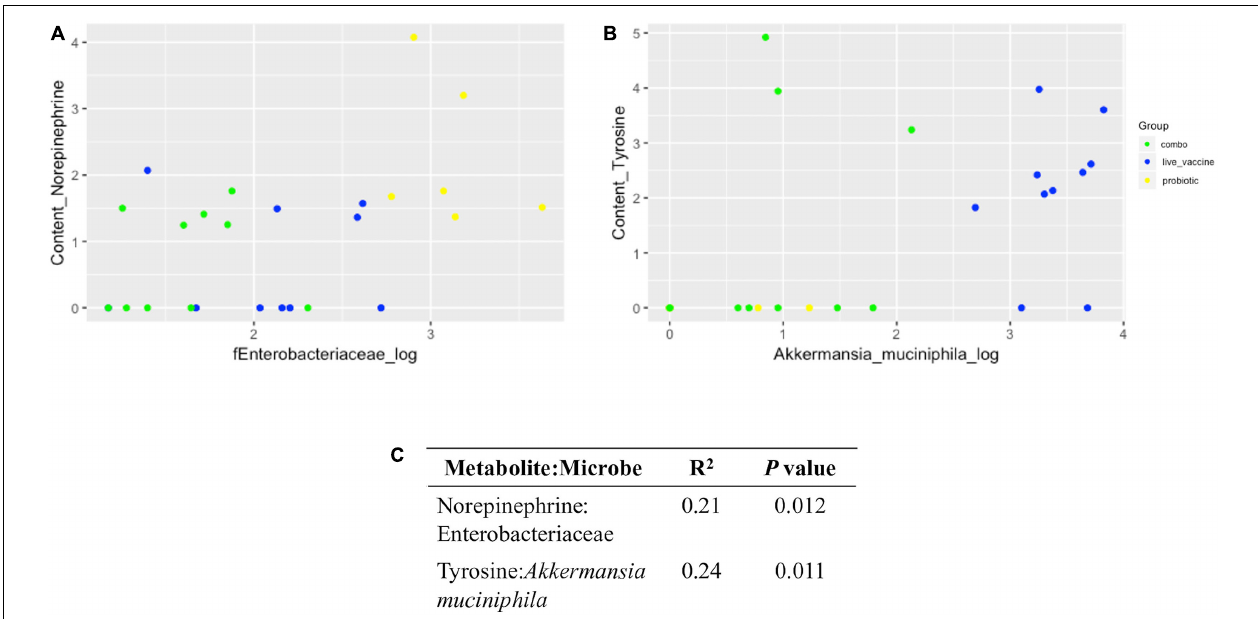
FIGURE 8 | Linear regression plots and output between neurochemical metabolites and microbial taxa in ceca content. Data were generated via R software. (A) Norepinephrine:Enterobacteriaceae; (B) tyrosine: Akkermansia muciniphila ; (C) , coefficient of determination ( R 2 ) and P value for each correlation. Yellow, PRO; blue, VAX; green,